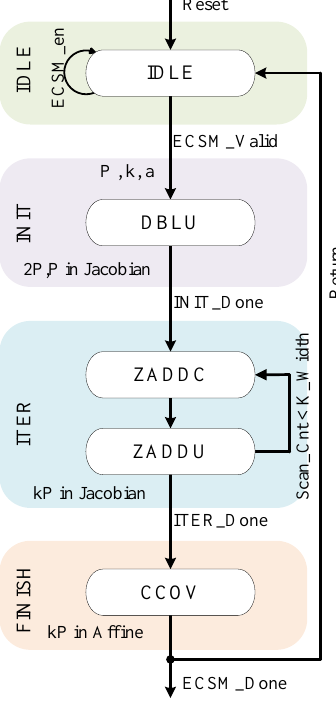
Figure 6. State transition diagram in